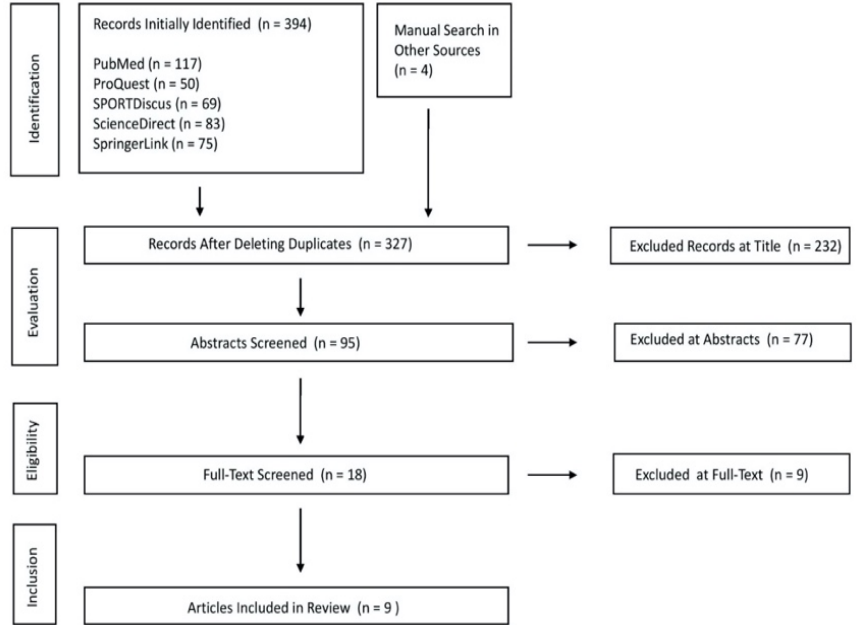
Figure 1. PRISMA search strategy.